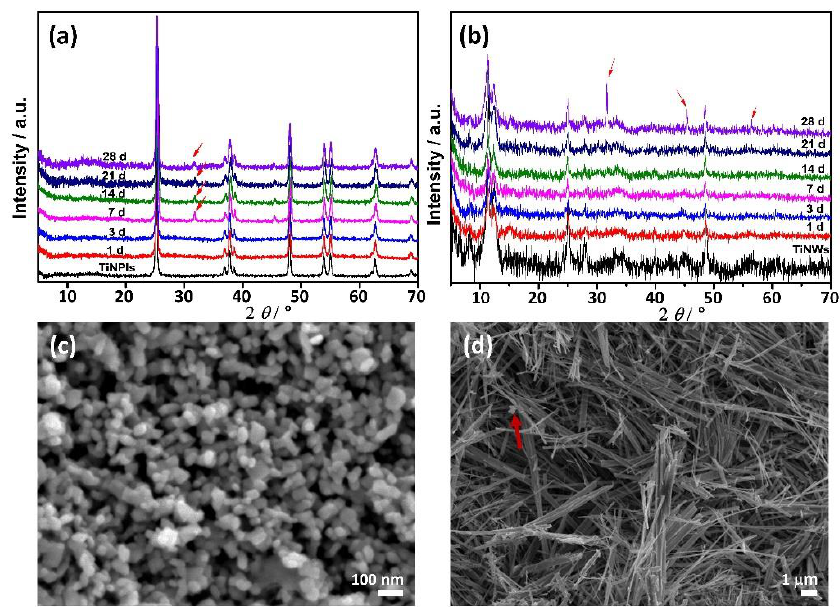
Figure 3. PXRD patterns ( a , b ) and SEM micrographs ( c , d ) of TiO 2 nanoplates (TiNPls) ( a , c ) and TiO 2 nanowires (TiNWs) ( b , d ) after soaking in corrected simulated body fluid for 1–28 d. SEM micrographs of the precipitates were obtained after 28 d. ϑ = (25.0 ± 0.1) °C. The red arrows indicate the presence of calcium deficient hydroxyapatite (CaDHA).